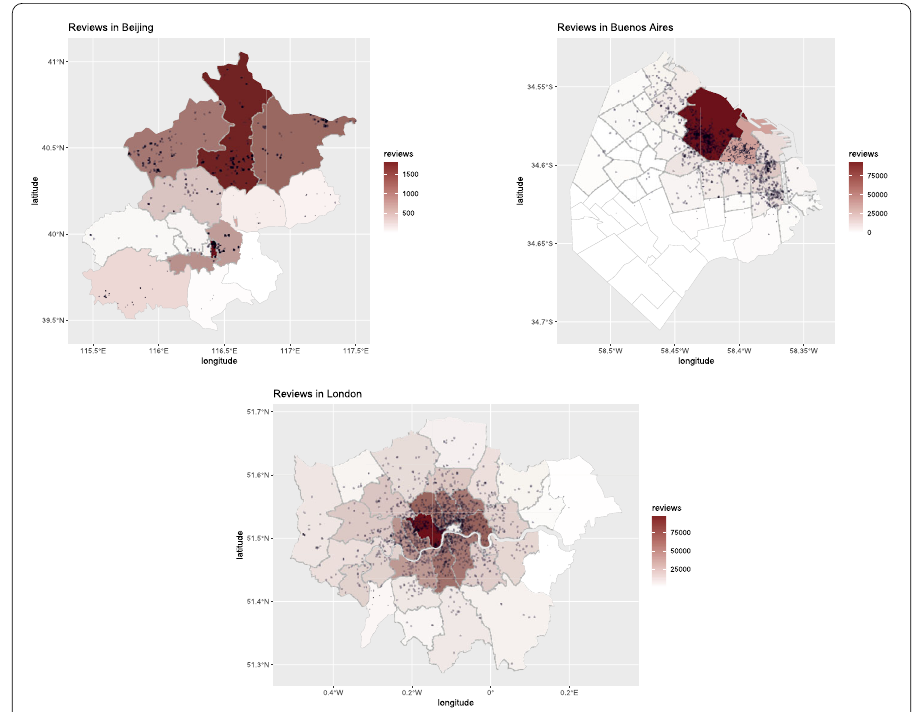
Figure 2 Demand (guest) density in Beijing, Buenos Aires and London